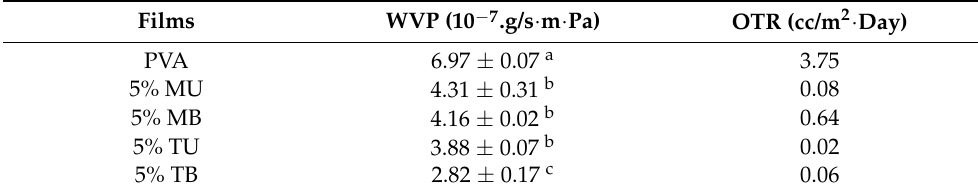
Table 1. Barrier properties of pure PVA and 5% PVA-(L)CNF